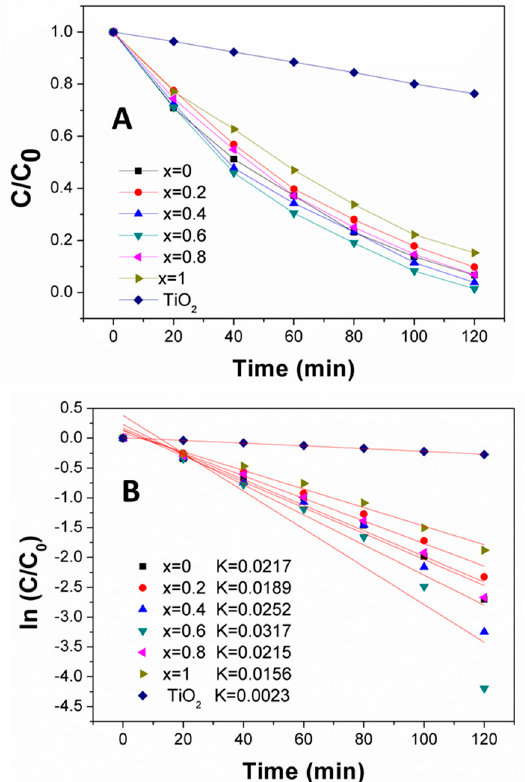
Figure 7. ( A ) Concentration change of methylene blue (MB) in the presence of pure TiO 2 particles, and Au x Ag (1 − x ) / TiO 2 composites with x = 0.2, 0.4, 0.6, 0.8 and 1 under sunlight irradiation. ( B ) Photodegradation rates of the pure TiO 2 particles, and Au x Ag (1 − x ) / TiO 2 composites with x = 0, 0.2, 0.4, 0.6, 0.8 and 1. Reaction rates (k) in the inset are calculated from the linear relationship between ln (C 0 / C) and time.